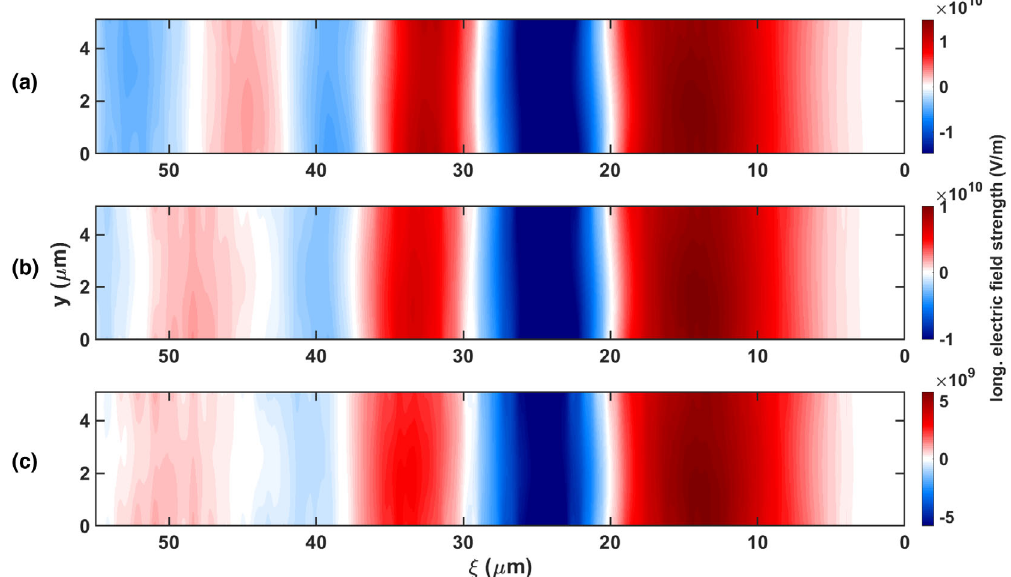
FIG. 6. Results of 2D PIC simulations for different laser amplitudes. The longitudinal electric field is plotted for (a) a 0 ¼ 0 . 9 , (b) a 0 ¼ 0 . 72 , and (c) a 0 ¼ 0 . 5 . The field is smoothed over 350 cells. The laser pulse is centered at 17 μ